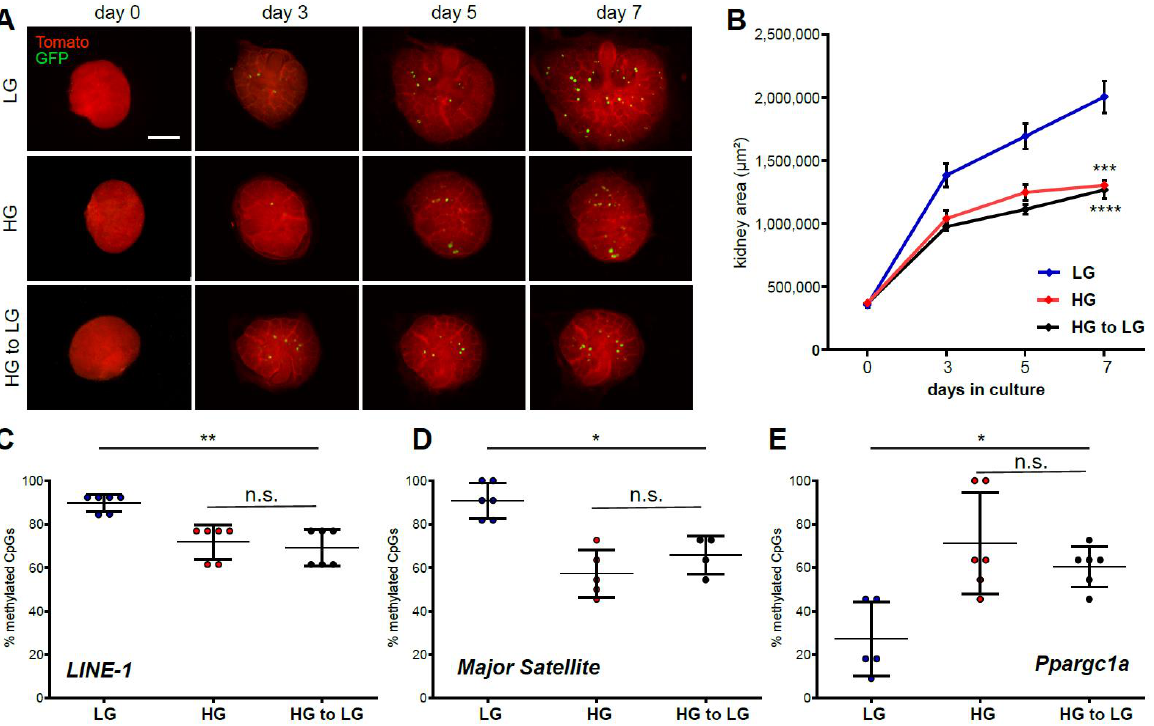
Figure 3. Ex vivo high glucose exposure influences long-term memory formation via DNA methylation. ( A ) Imaging of E12.5 embryonic kidneys from day 0 to day 7 in low glucose medium (5.5 mM), high glucose medium (55 mM) or high glucose medium for 3.5 days and reversal to low glucose medium for the remaining days. Scale bar: 500 µm. ( B ) Kidney surface area over 7 days. Mean ± SD. n = 36 kidneys. LG, low glucose treatment; HG, high glucose treatment; HG to LG, 3.5 days high and 3.5 days low glucose treatment. ***, LG–HG (unpaired t -test): p = 0.0004; ****, LG–HG to LG (paired t -test): p < 0.0001. ( C ) Analysis of the DNA methylation at LINE -1 and ( D ) major satellite loci shows continuous DNA hypomethylation in high glucose treated conditions. **, p -value = 0.0022. *, p -value = 0.0357. ( E ) Analysis of the DNA methylation at Ppargc1a locus shows continuous DNA hypermethylation in high glucose conditions. Mean ± SD. *, p -value = 0.0130.